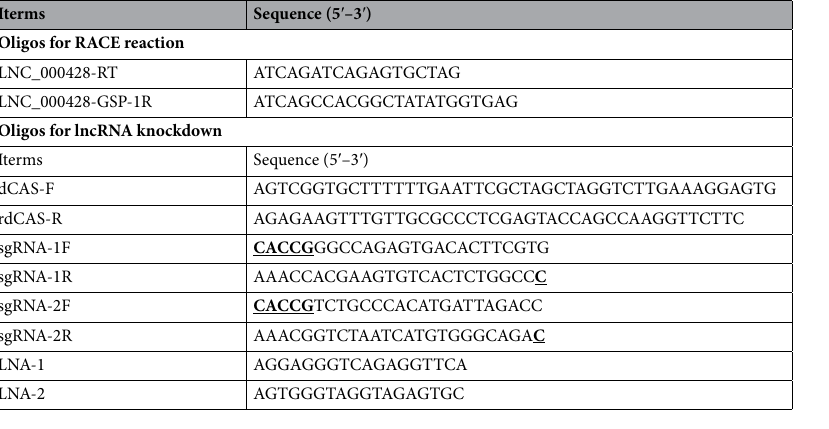
Table 1. Oligos for RACE and knockdown of LNC_000428 in this study. Bold and underlined: sticky ends for sgRNA